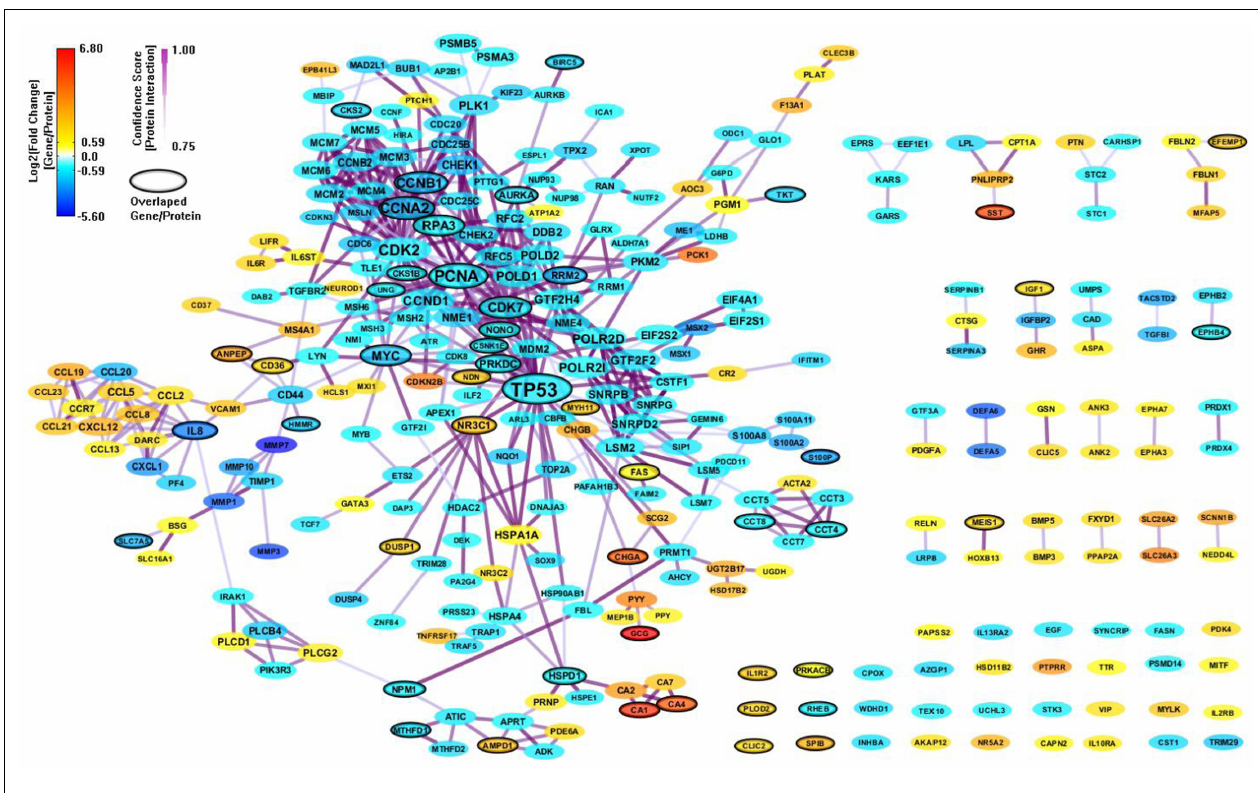
GeneSigDB. Node colors represent differential gene expressions, node size represents the local topological property, edge color, and edge width represents confidence score for each protein interaction. Black-circled genes represent the enriched genes from both MSigDB and